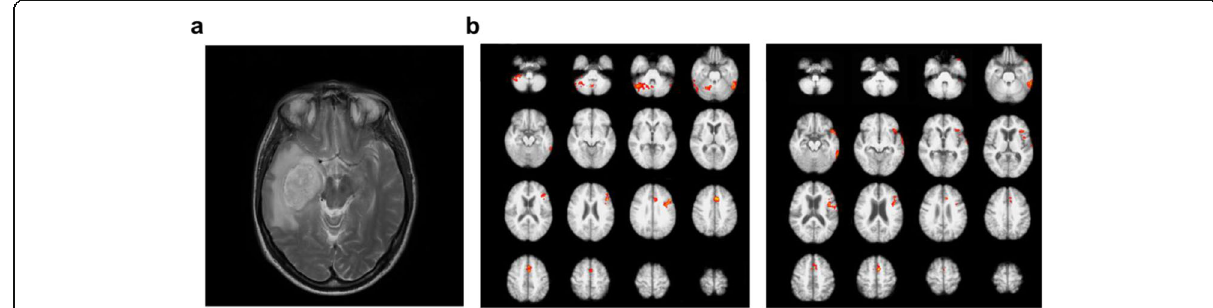
Fig. 1 Modality of MRI/fMRI. a Axial MRI slice of a patient with a brain tumor. b BOLD dependent fMRI scans of verbal fluency task performed by healthy controls (left) and subjects with alzheimer ’ s disease (right). Adapted with permission from Crowe et al. 2017 ( a ) and from Preti et al. 2014 ( b